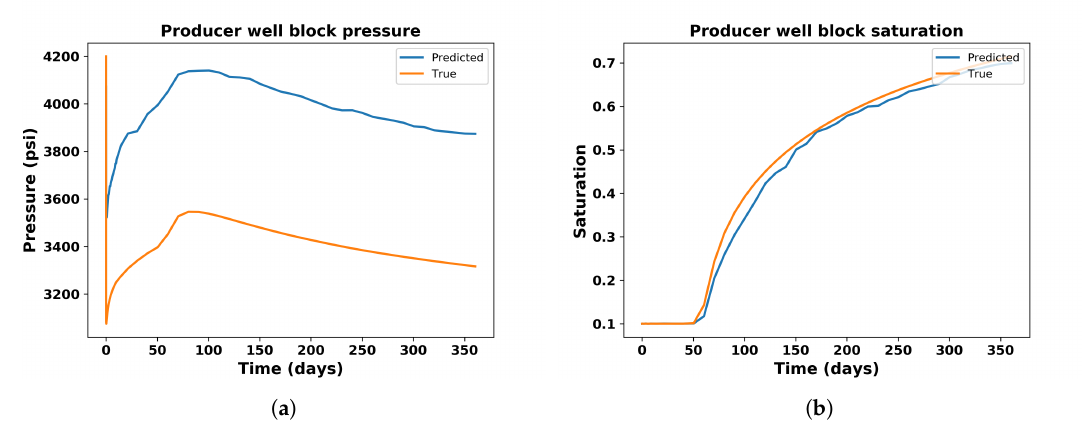
Figure 11. Well block state solution comparison ( a ) Pressure and ( b ) Saturation.